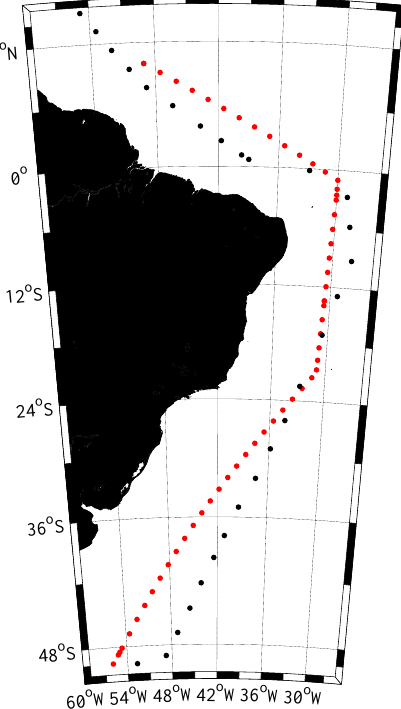
Figure 1. Stations where DIC and A T samples were taken from both cruises (black represents the WOCE ‘94 A17 stations; red rep- resents the GEOTRACES-NL (2010/2011) expeditions).